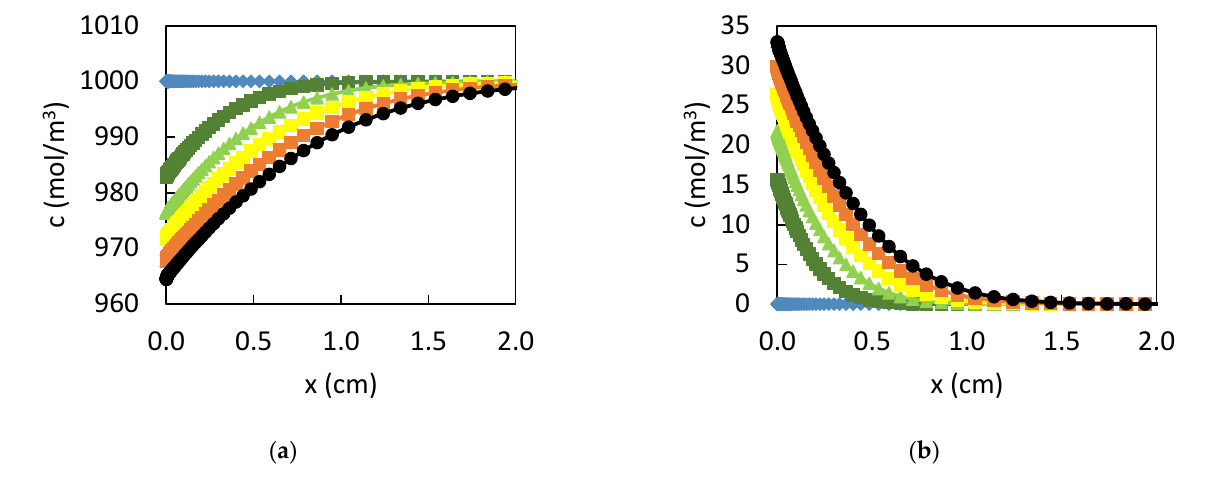
Figure 15. Evolution of ( a ) the protons and ( b ) H 2 concentration in an electrolyte of 1000 mol/m 3 HCl and of size L = 10 cm with an initial CPL of 100 µm and a fixed porosity of 0.9. The first 2 cm of the electrolyte are presented for different times t = 0 s (light blue), 3600 s (dark green) 7200 s (green), 10,800 s (yellow), 14,400 s (orange), and 18,000 s (black).